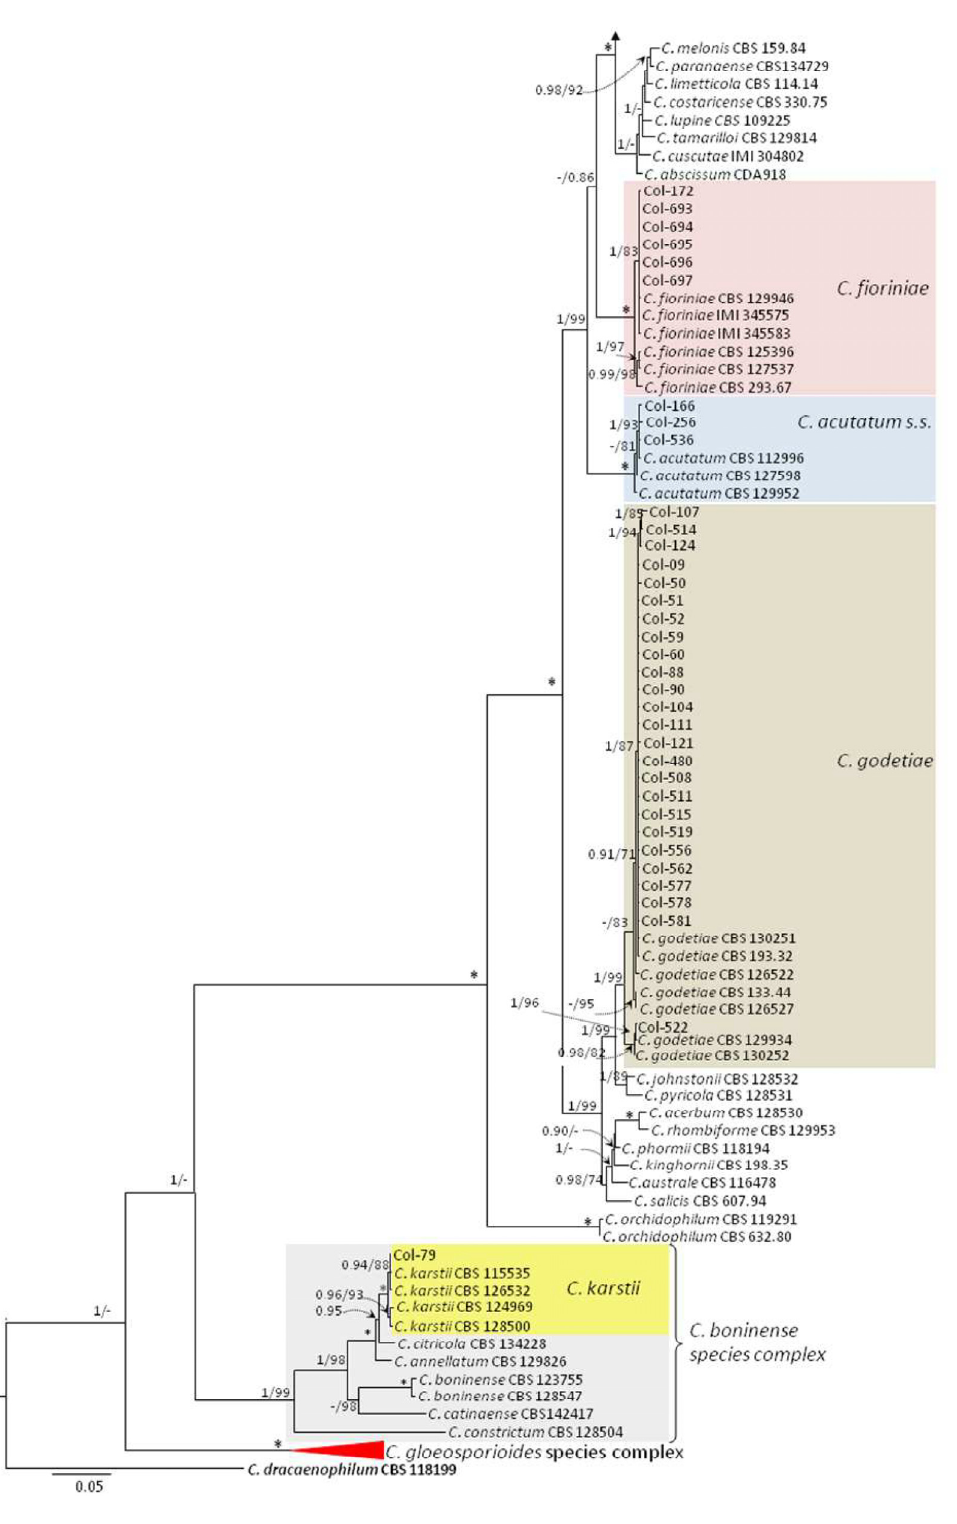
Figure 4. Phylogenetic tree obtained by Bayesian analysis using the combined ITS, TUB2, ACT, CHS-1, HIS3, and GAPDH sequence alignments of Colletotrichum acutatum , C. boninense , and C. gloeosporioides species complexes. Bayesian posterior probabilities (PP, > 0.9) and bootstrap support values (MP, (BS) > 70%) of maximum parsimony analysis are shown in the nodes (PP/MP). The asterisk (*) indicates full support (1/100). Colletotrichum dracaenophilum (CBS 118199) was used as out- group.